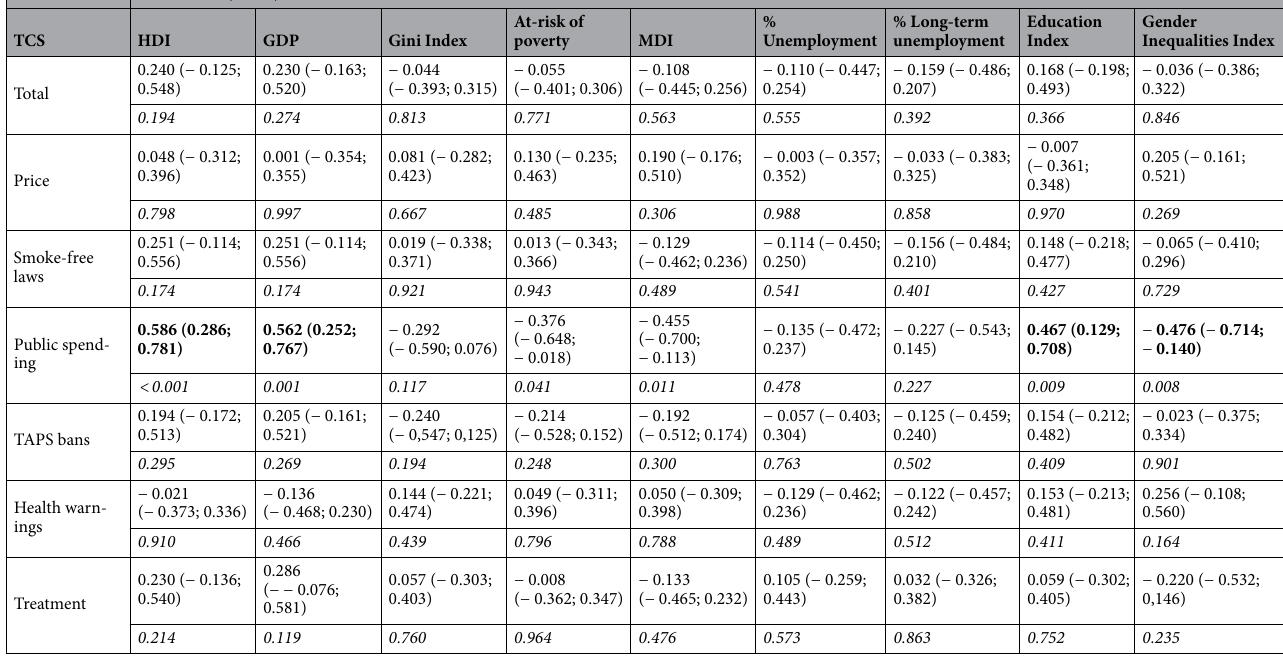
Table 3. Spearman’s rank-correlation coefficients (r sp ) and 95% confidence intervals (CI) between socioeconomic status (SES) indicators and Tobacco Control Scale (TCS) scores in 2016 (overall and by components) in 31 European countries. Note: Bold, p value < 0.01. TAPS: Tobacco, advertising, promotion, and sponsorship; HDI: Human Development Index; GDP: Gross-domestic Product per capita (in Euros); MDI: Material Deprivation Index.